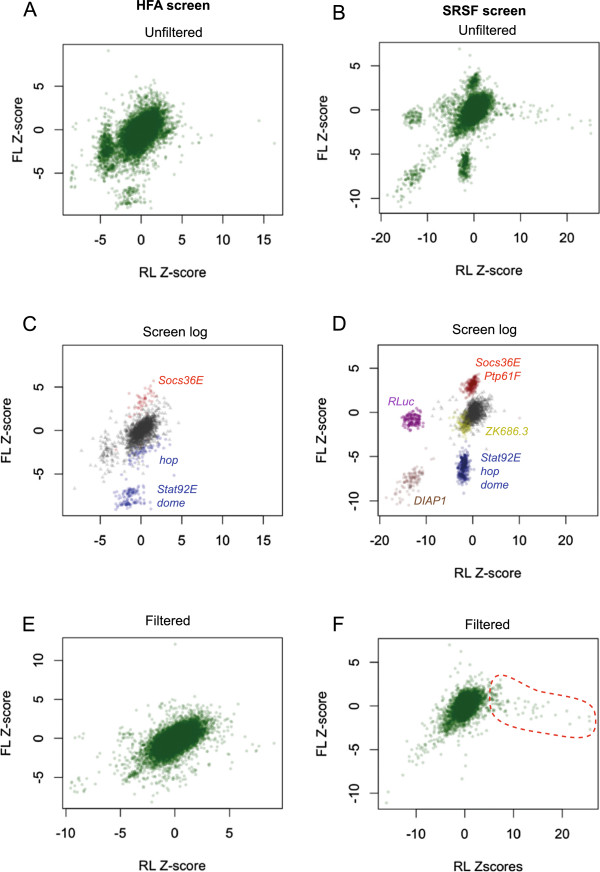
Analysis of separate luciferase channels Scatter plots showing Z-scores of RL vs FL channels for HFA screen (A, C, E) and SRSF screen (B,D,F). Wells from the screen log files, used to exclude data from the analysis, are shown for the HFA (C) and SRSF (D) screens. The positions of wells containing the indicated control dsRNAs are indicated in their corresponding colours, while grey triangles signify wells with errors or empty of dsRNA. (E and F) Show fully filtered data for each screen.